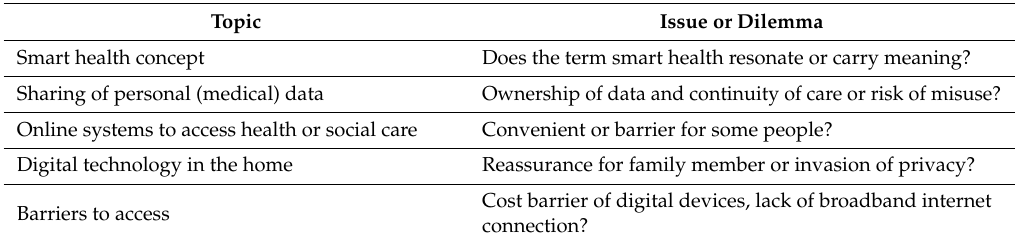
Table 1. Table of topics and dilemmas discussed within the citizens’ juries.